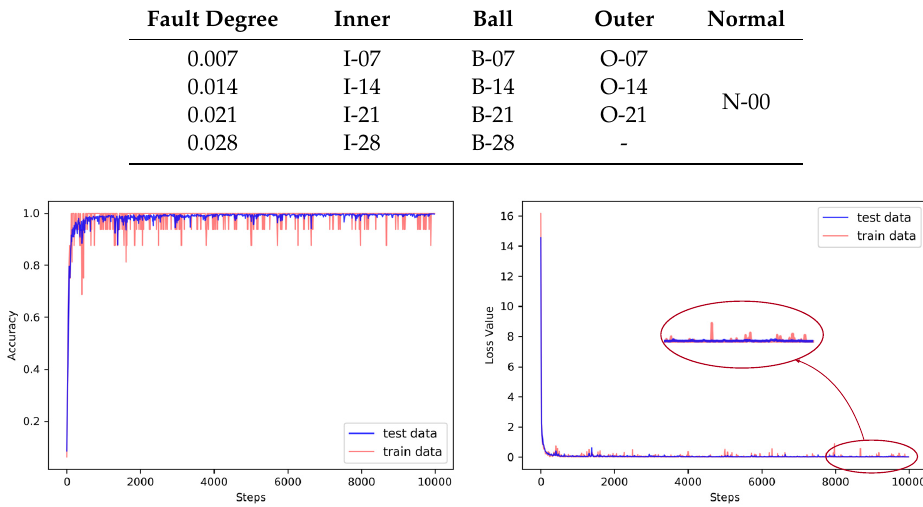
Figure 9. The trends of accuracy and loss value with the number of training steps.